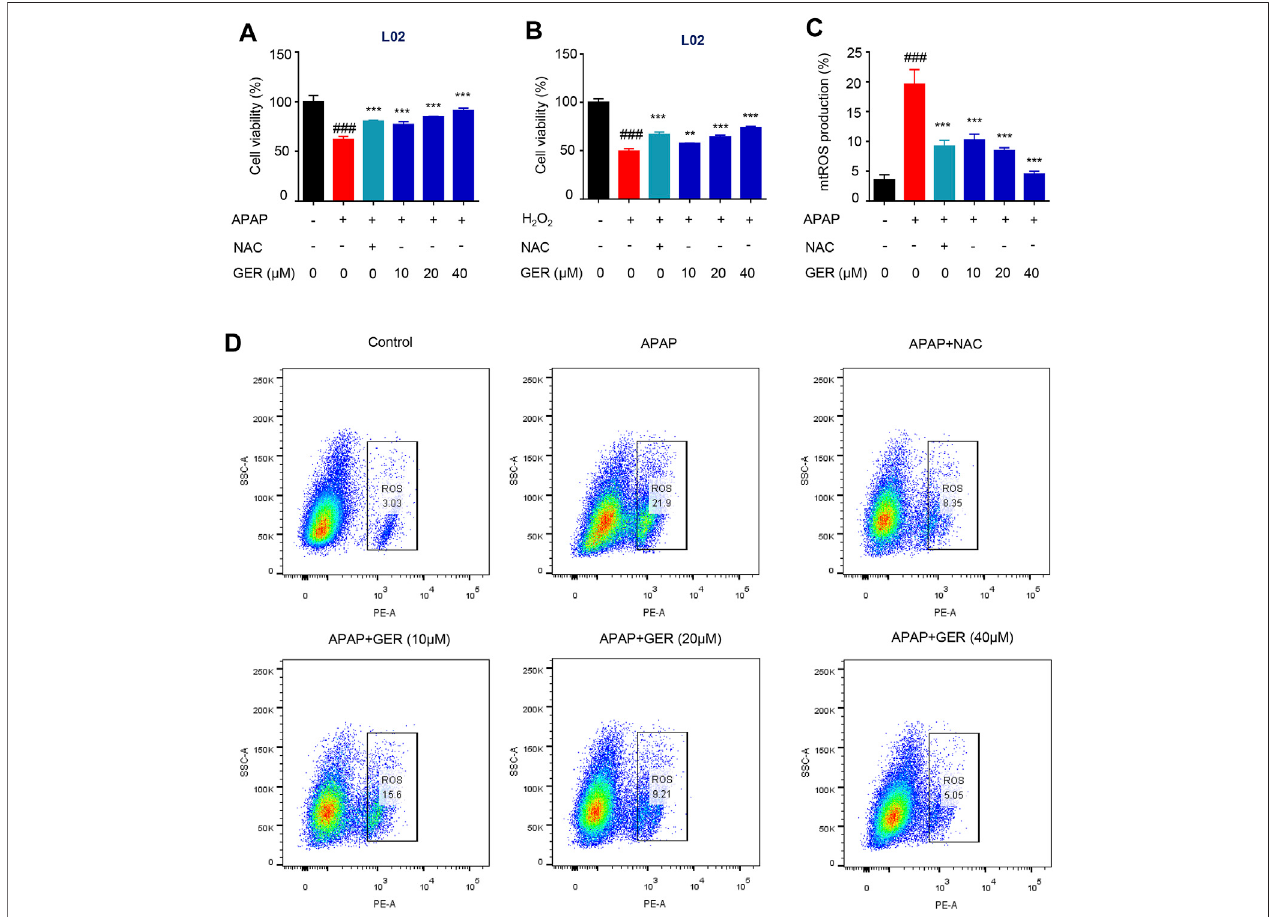
FIGURE 4 | GER protects the hepatocyte by inhibiting the release of mitochondrial ROS in vitro . (A) L02 cells were treated with APAP (20 mM) for 12 h, and then were treated with GER or NAC for 24 h, then the cell viability was detected by CCK-8 ( n (cid:2) 3). (B) L02 cells were treated with H 2 O 2 (600 μ M) for 12 h, and then were treatedwith GERor NAC for24 h, then thecell viabilitywas detected by CCK-8 ( n (cid:2) 3). (C) Quantitative analysisofdifferent group mitochondrial ROSrelease ( n (cid:2) 3). (D) Flow cytometric analysis of the cell proportion of mitochondrial ROS in L02. The NAC was used as positive control, every group was treated with APAP except for control group. All data are presented as means ± SEM. ### p < 0.001 vs. the control group. ** p < 0.01, *** p < 0.001 vs. the APAP